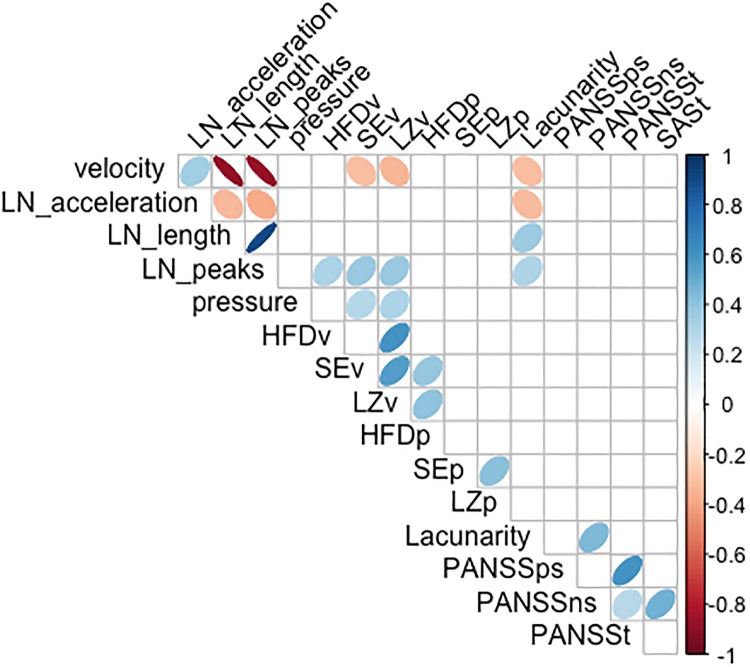
Spearman coefficients for SAS, PANSS and the handwriting variables.